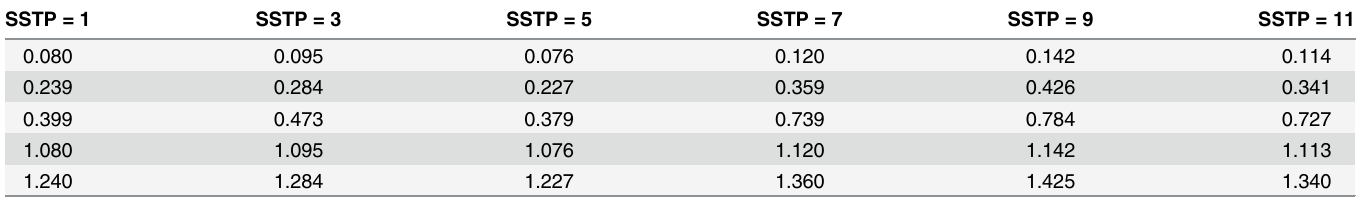
Table 3. The time points t i of lucky prognoses in Jetsu et